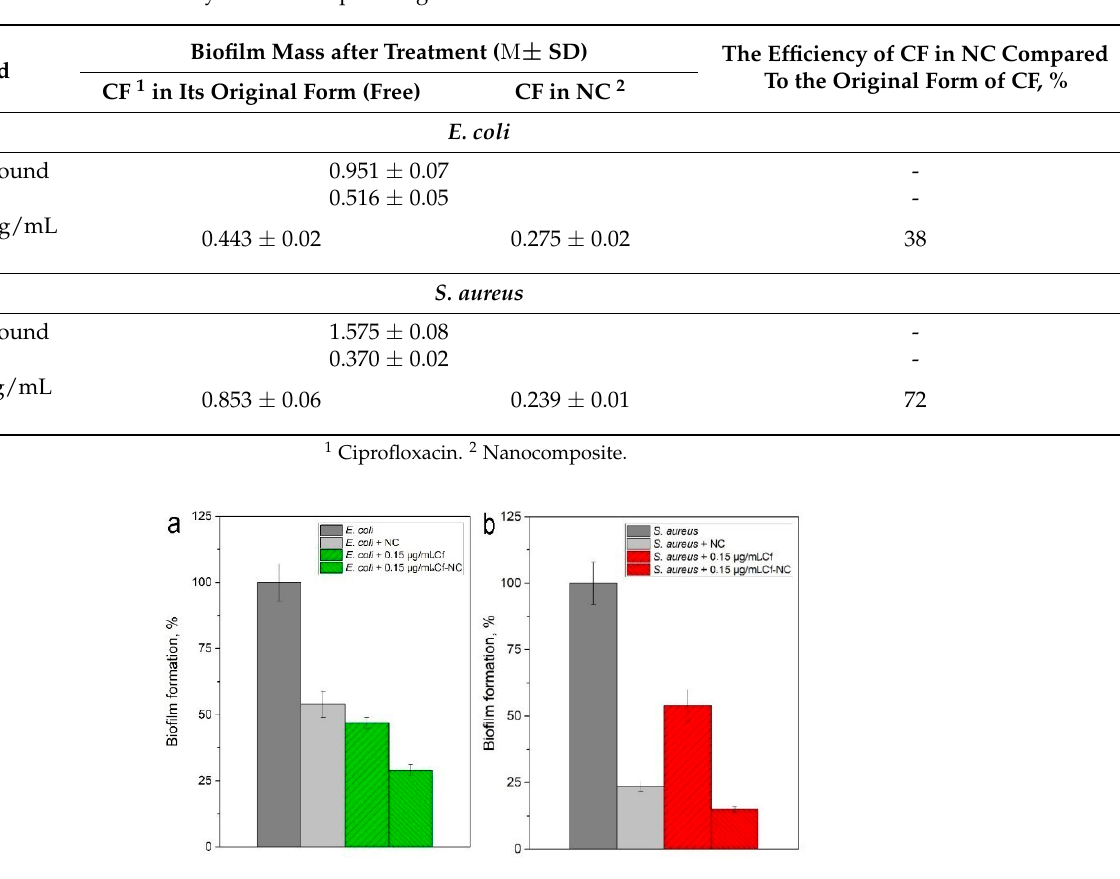
Figure 5. Efficacy of nanocomposite against the formed biofilms of ( a ) E. coli and ( b ) S. aureus . NC-treatment with a nanocomposite without antibiotic; Cf-treatment with ciprofloxacin; Cf-NC-treatment with ciprofloxacin immobilized in a nanocomposite.